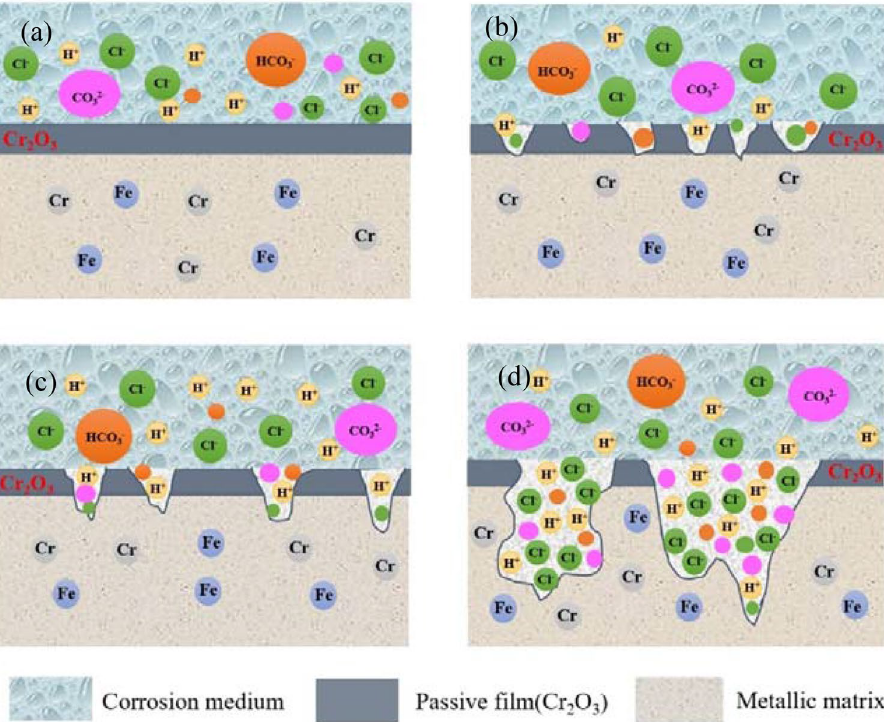
Figure 11. Corrosion process of 2205 DSS and formation and fracture of new film. ( a ) Process 1, ( b ) Process 2, ( c ) Process 3, ( d ) Process